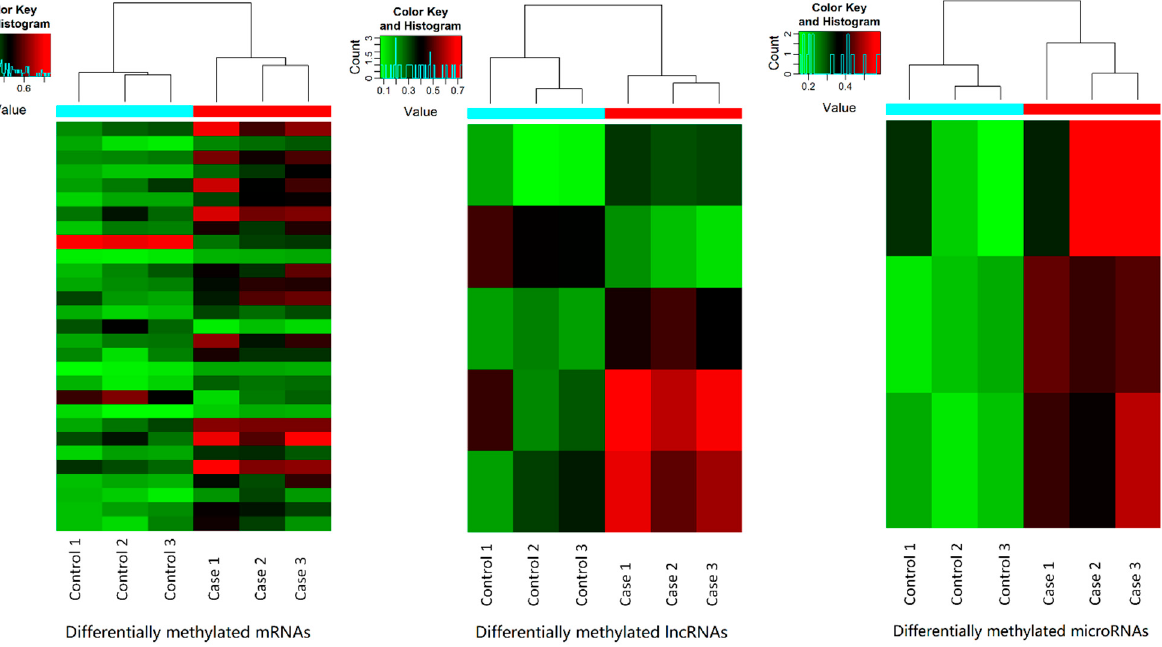
Figure 2. Volcano plots displaying differentially methylated RNAs (mRNAs, lncRNAs, and miRNAs) in postmortem nucleus accumbens (NAc) of subjects with alcohol use disorder (AUD). The vertical axis (y-axis) corresponds to the negative log 10 of the p -value, and the horizontal axis (x-axis) displays the log 2 of fold changes (FC). The red dots represent up-regulated RNAs (log 2 FC > 1.0 and p < 0.05) and the green dots represent downregulated RNAs (log 2 FC < − 1.0 and p < 0.05). The horizontal line shows the p -value cutoff ( p = 0.05) with points above the line having the p -value < 0.05 and points below the line having the p -value > 0.05. The two vertical lines indicate 2-fold changes. Table 2. Differentially methylated mRNAs, lncRNAs, and miRNAs in postmortem NAc of AUD